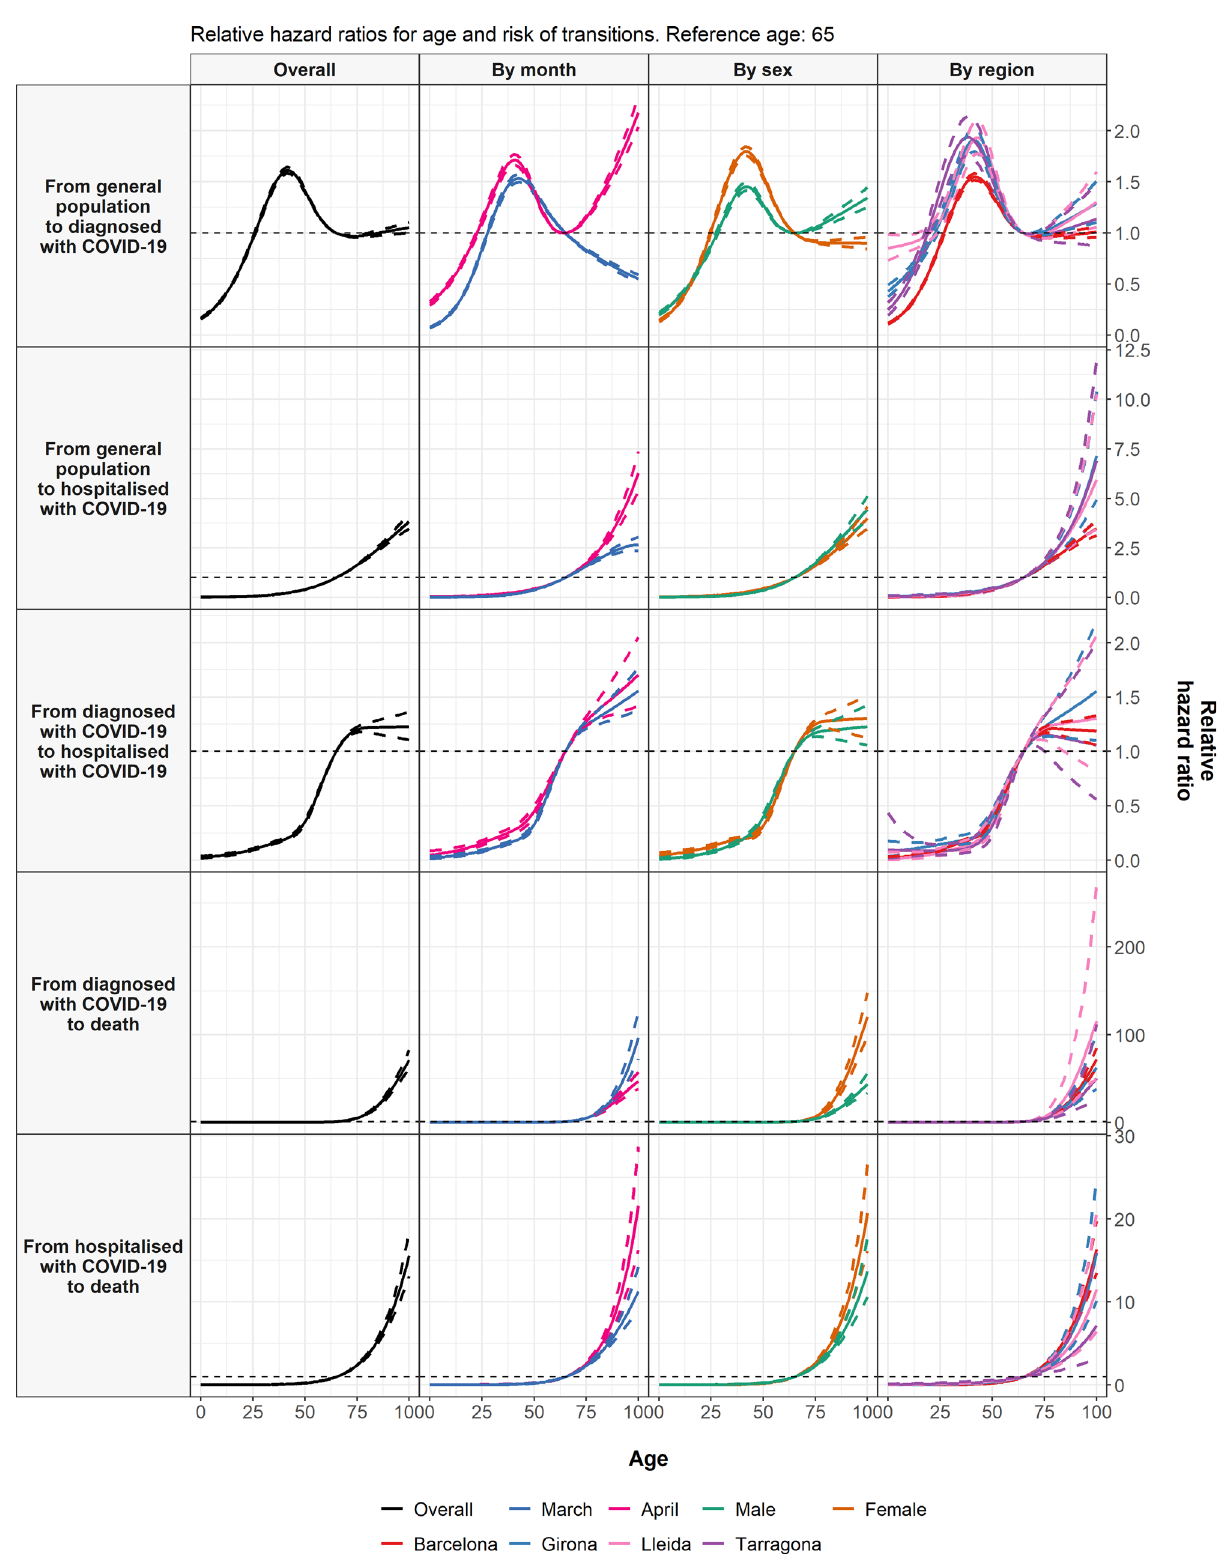
Fig. 4 Age and COVID-19 transitions. Estimated hazard ratios for age (relative to a reference age of 65) from cause-speci fi c Cox models for each transition. Dotted lines represent 95% con fi dence intervals. The models shown included age as the only explanatory variable, with the overall models and models strati fi ed by calendar month, sex, and region